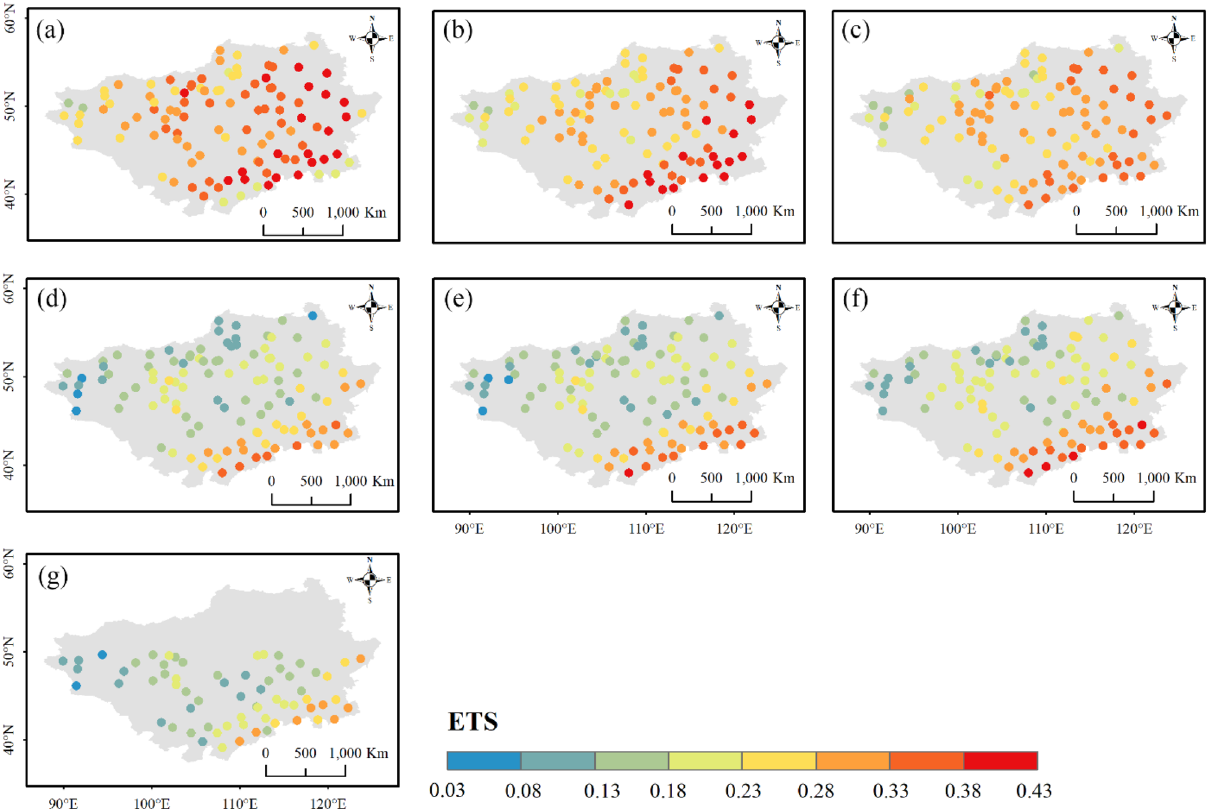
Figure 14. Spatial distribution of ETS for ( a ) ERA5-Land, ( b ) ERA5-HRES, ( c ) ERA-Interim, ( d ) IMERG ER, ( e ) IMERG LR, ( f ) IMERG FR, and ( g ) TMPA-3B42. For subplot ( g ), only stations within the spatial coverage of TMPA-3B42 (50° N–50° S) were plotted. The figure was created using ArcGIS 10.7 (https:// www. esri. com/ en- us/ arcgis/ about- arcgis/ overv iew) 70